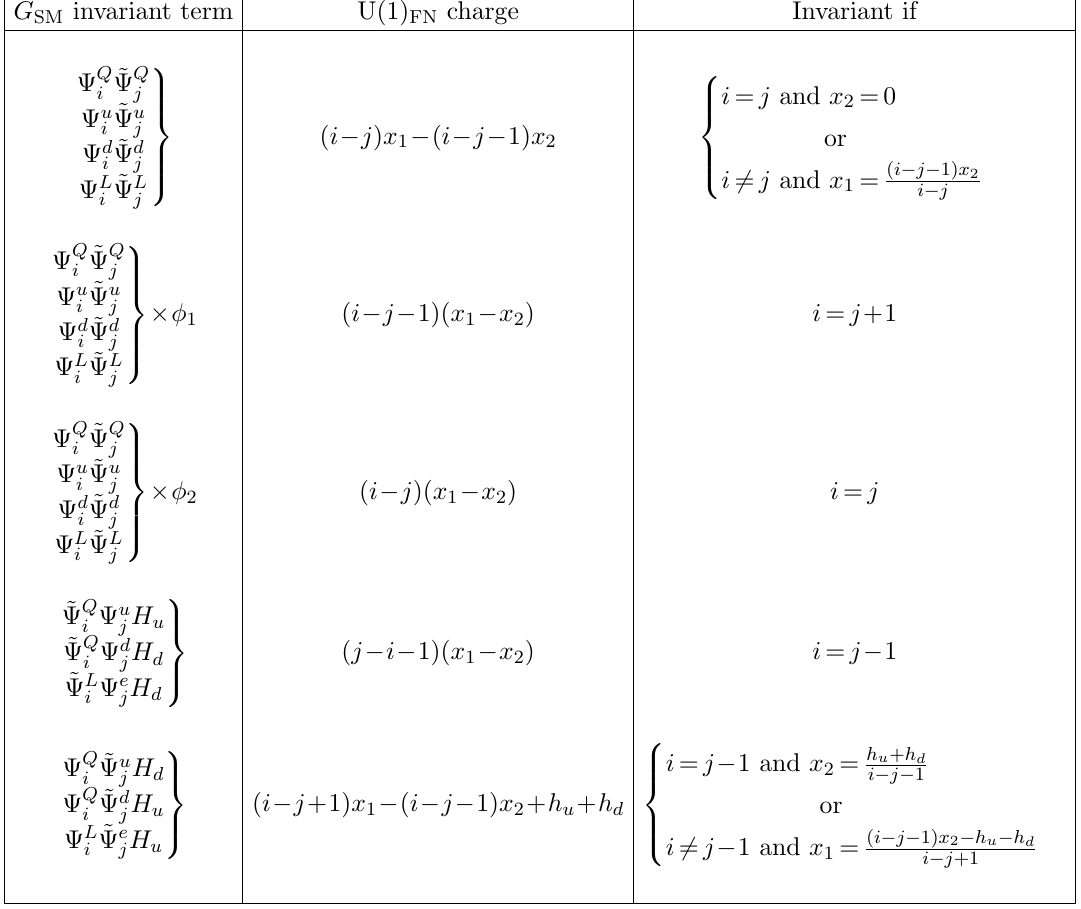
Table 4 . G SM -invariant superpotential terms formed with super(cid:12)elds de(cid:12)ned in section